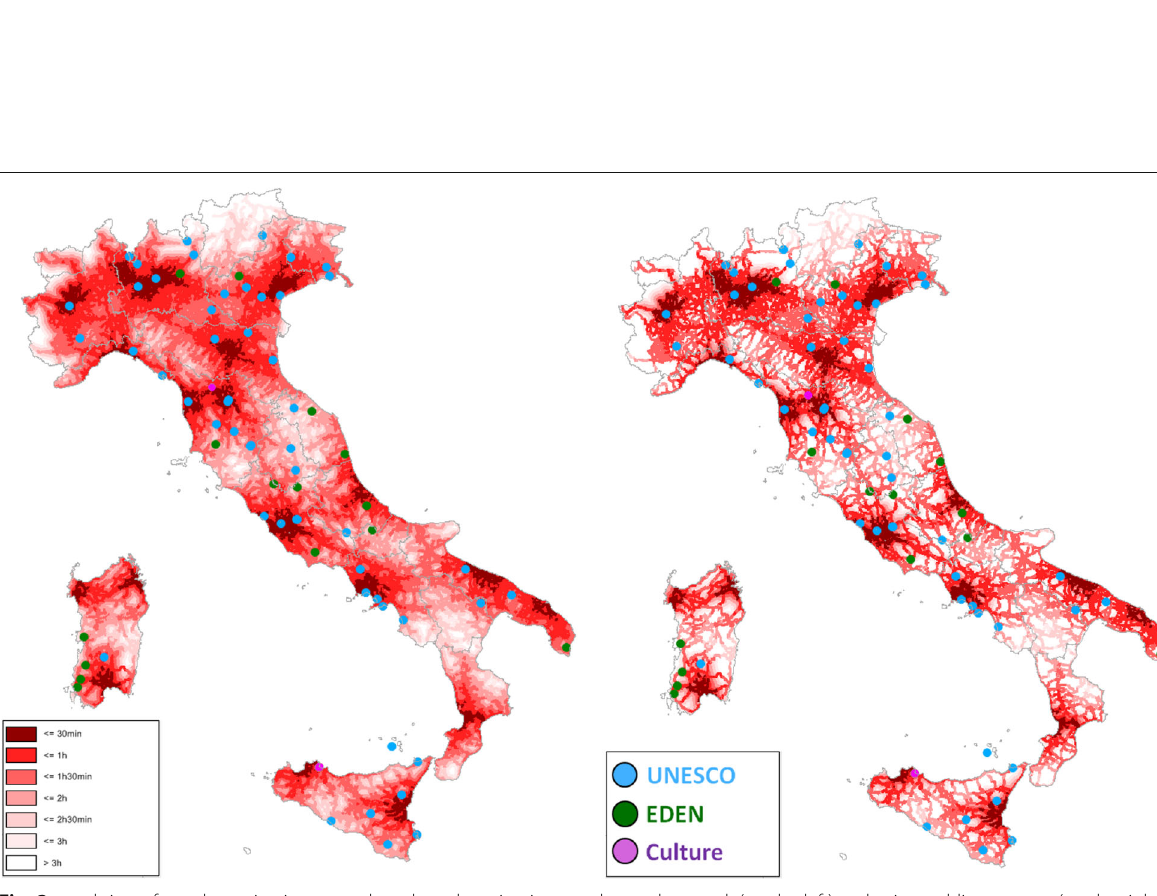
Fig. 3 travel times from the main airports to the selected tourist sites, on the road network (on the left) and using public transport (on the